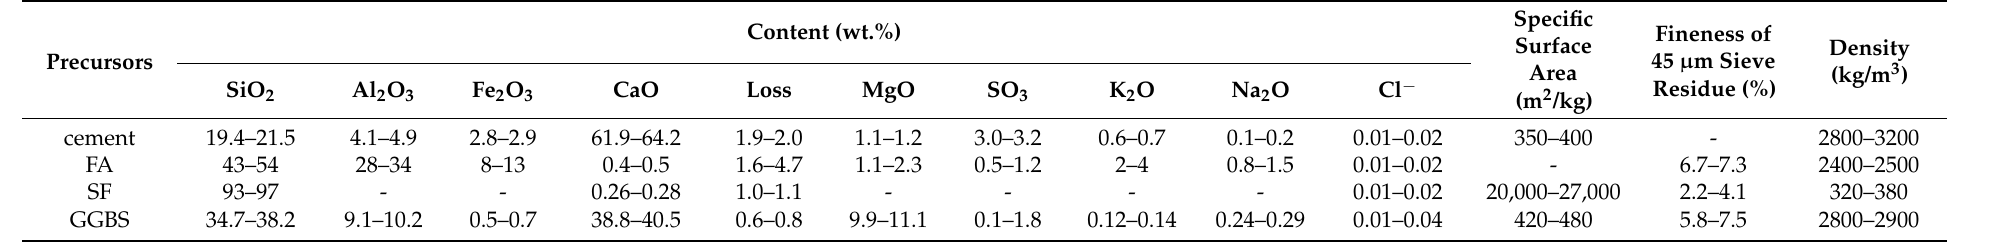
Table 1. Chemical compositions, specific surface area, fineness of 45 µ m sieve residue, and density of the cement, FA, SF, and GGBS (wt.%).